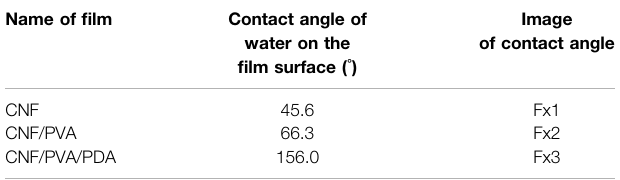
TABLE 1 | The contact angle on the surface of CNF, CNF/PVA and CNF/PVA/ PDA fi